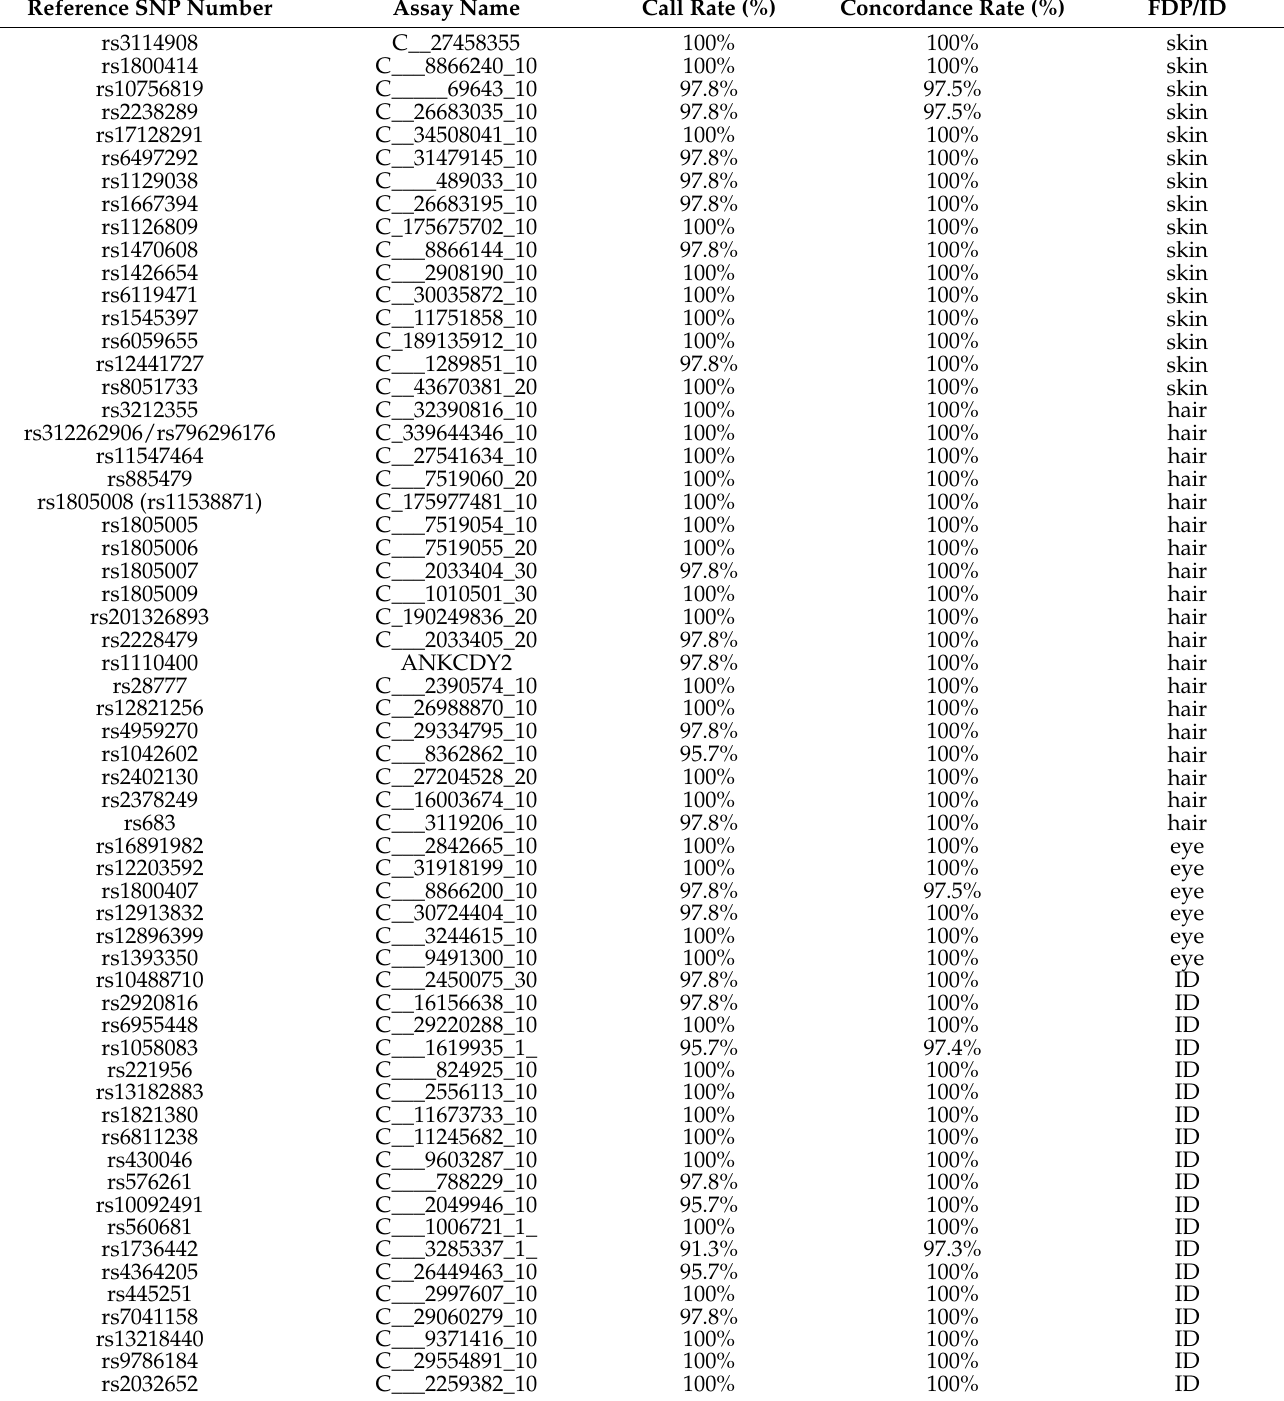
Table 1. Single-nucleotide polymorphism (SNP) details. FDP: forensic DNA phenotyping; ID: SNPs for forensic identifica- tion